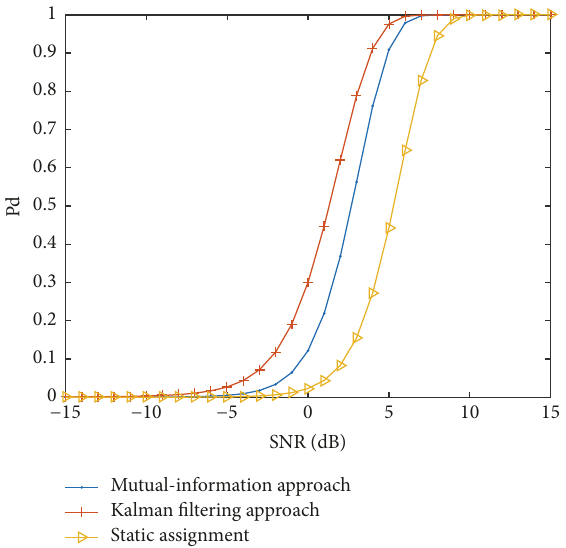
Figure 6: Detection probability for optimization waveforms based on Kalman filtering approach and random waveform.